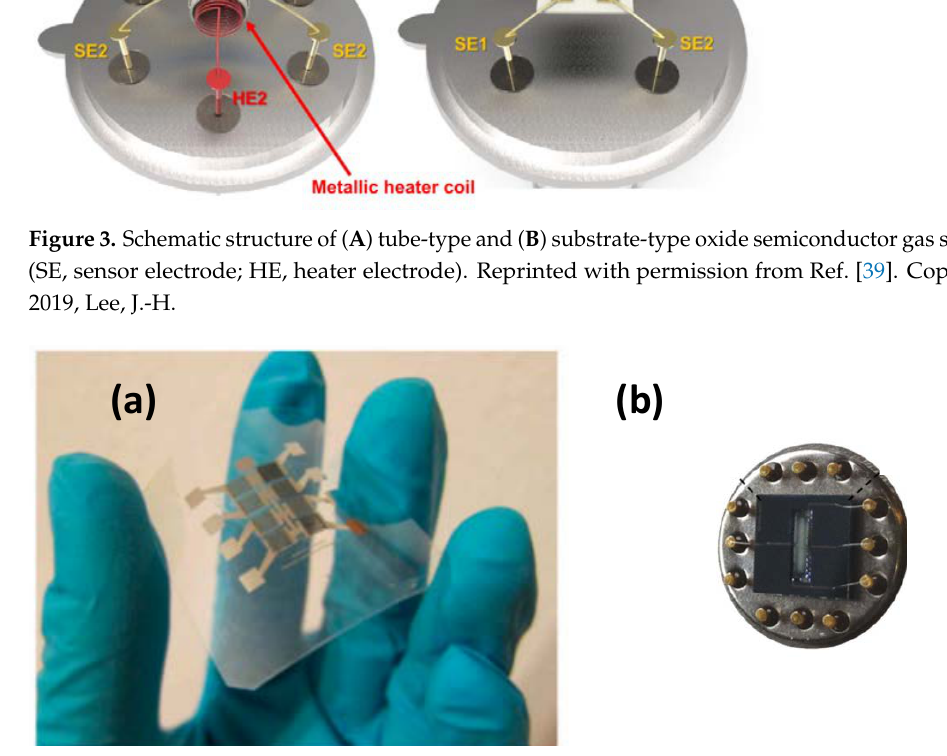
Figure 3. Schematic structure of ( A ) tube-type and ( B ) substrate-type oxide semiconductor gas sensors (SE, sensor electrode; HE, heater electrode), “Reprinted/adapted with permission from Ref. [39]. 2019, Lee, J.-H.”.